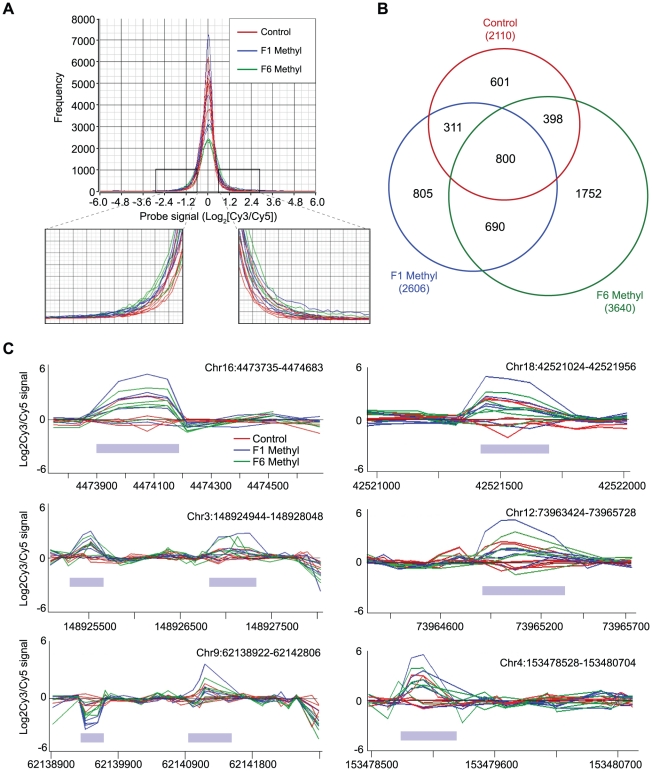
Methylation-variable regions in unsupplemented and supplemented
mice.(A) Histogram showing frequency distribution of normalised array probe
signals from control and F1 and F6 supplemented mice. The areas of the
histogram showing the lowest and highest signals (representing the
greatest losses or gains in methylation relative to the control pool)
are magnified. (B) Venn diagram showing overlap of loci identified as
methylation-variable between unsupplemented and F1 and F6 supplemented
mice. The total number of methylation-variable loci in each group is
shown in parentheses. (C) Microarray signals from six representative
methylation-variable loci. Note that an increase in signal indicates
relative hypomethylation. Grey bars indicate
methylation-variable regions.